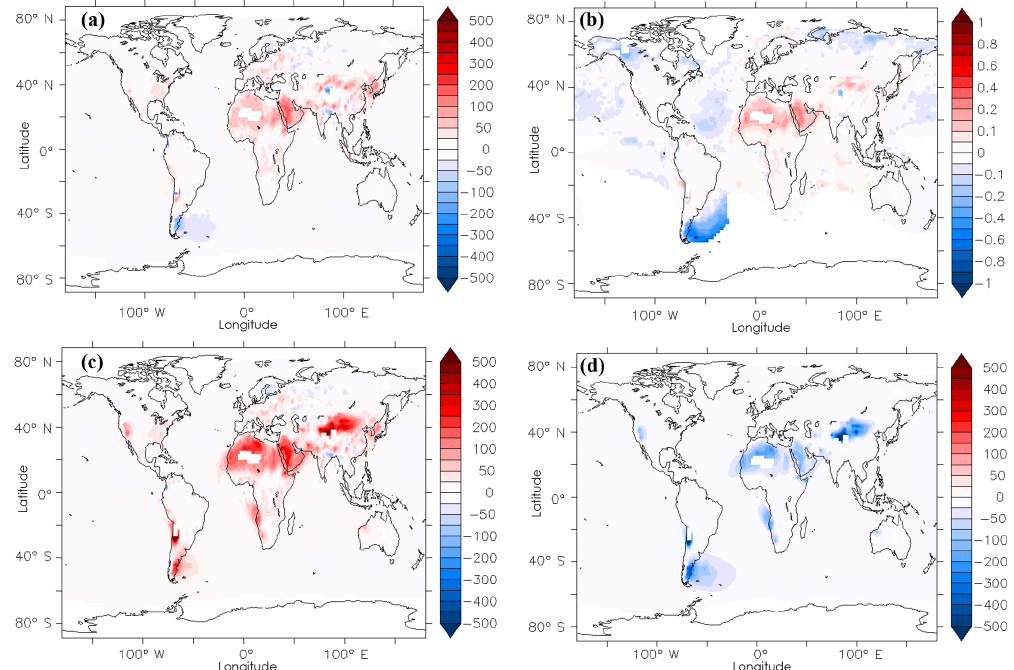
Figure 7. (a) Absolute (in cm − 3 ) and (b) fractional annual average change in the predicted total CDNC, and absolute (in cm − 3 ) annual aver- age change in the CDNC from (c) soluble, and (d) insoluble particle modes, by switching on/off the mineral dust chemistry. Concentrations reported at the lowest cloud-forming level (940hPa). A positive change corresponds to an increase from dust–chemistry interactions.